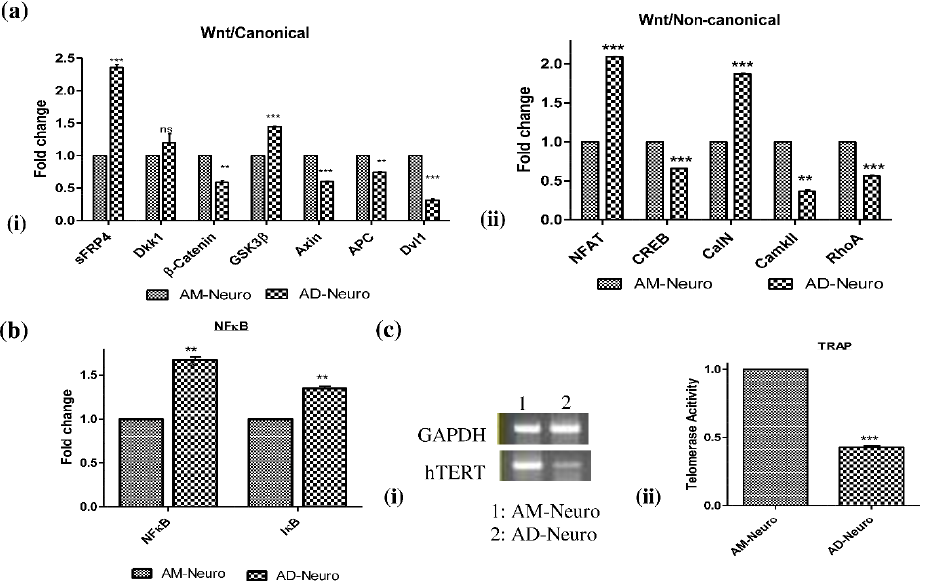
Figure 4. Molecular modulators of Alzheimer’s disease. ( a ) qRT-PCR analysis showing ( i ) downregulation of Wnt/canonical pathway genes- β -catenin, Axin, APC and Dvl1 and increase in expression of GSK3β along with Wnt antagonists, sFRP4 and Dkk1, ( ii ) expression of Wnt/non-canonical pathway genes: NFAT, CREB, CalN, CaMKII and RhoA. ( b ) qRT-PCR data showing increase in NFκB pathway genes, NFκB and IκB in AD -neuro cells. Data are represented as mean with SEM ( n = 3), ** p < 0.01 *** p < 0.001. ( c ) ( i ) RT-PCR analysis showing downregulation in hTERT gene in AD-Neuro cells compared to AM-Neuro cells (control), ( ii ) decrease in telomerase activity confirmed by TRAP assay. Data are represented as mean with SEM ( n = 3), *** p < 0.001.